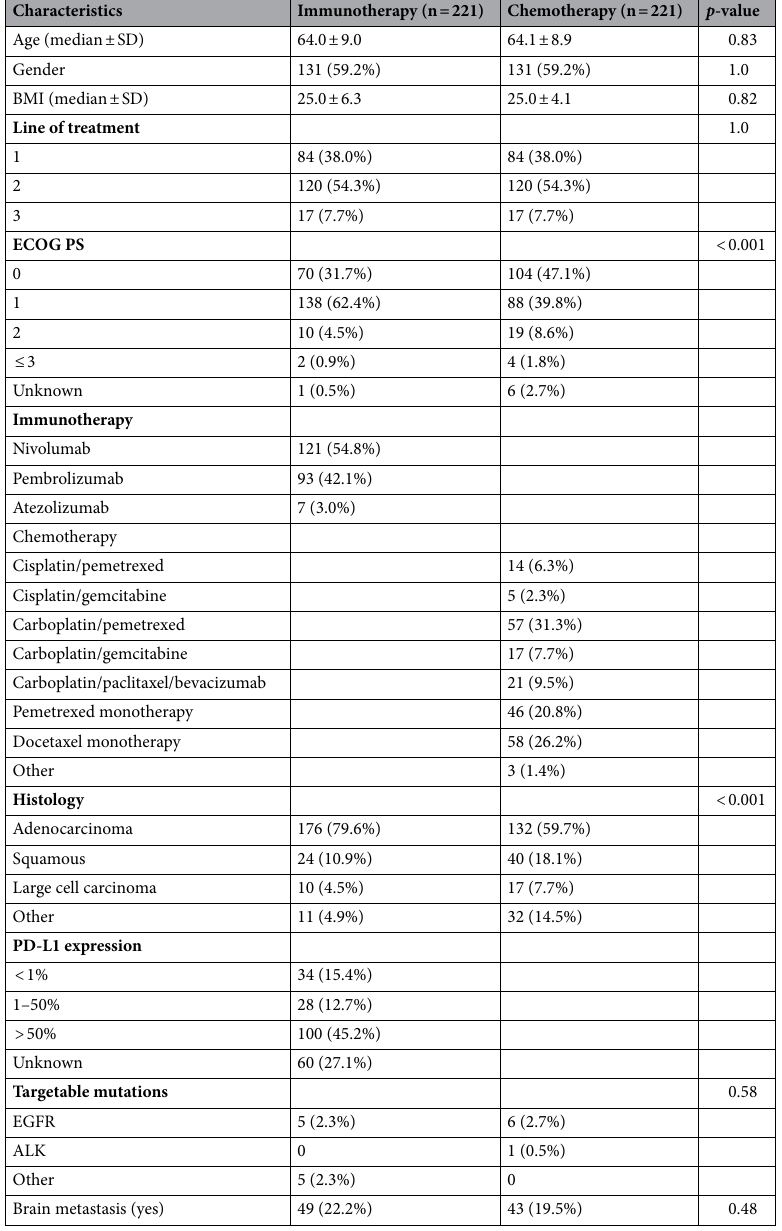
Table 1. Patient characteristics of stage IV NSCLC patients treated with immunotherapy and chemotherapy. Abbreviations: ECOG PS, Eastern Cooperative Group performance status; BMI, Body mass index; PD-L1, programmed death ligand-1.